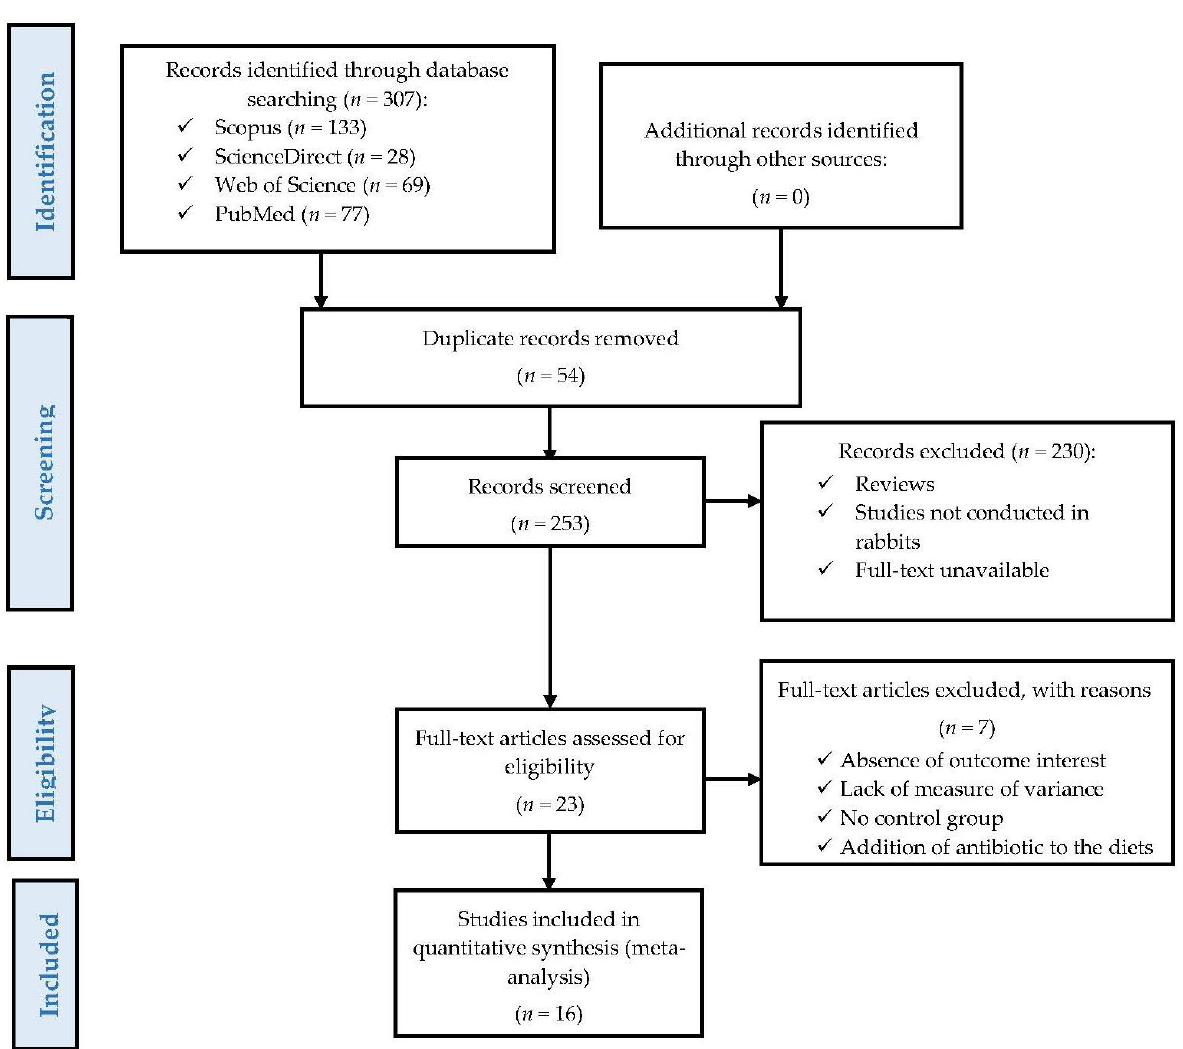
Figure A1. A PRISMA flow diagram detailing the literature search strategy and study selection for the meta-analysis. Table A1. Summary of the studies included in the meta-analysis.